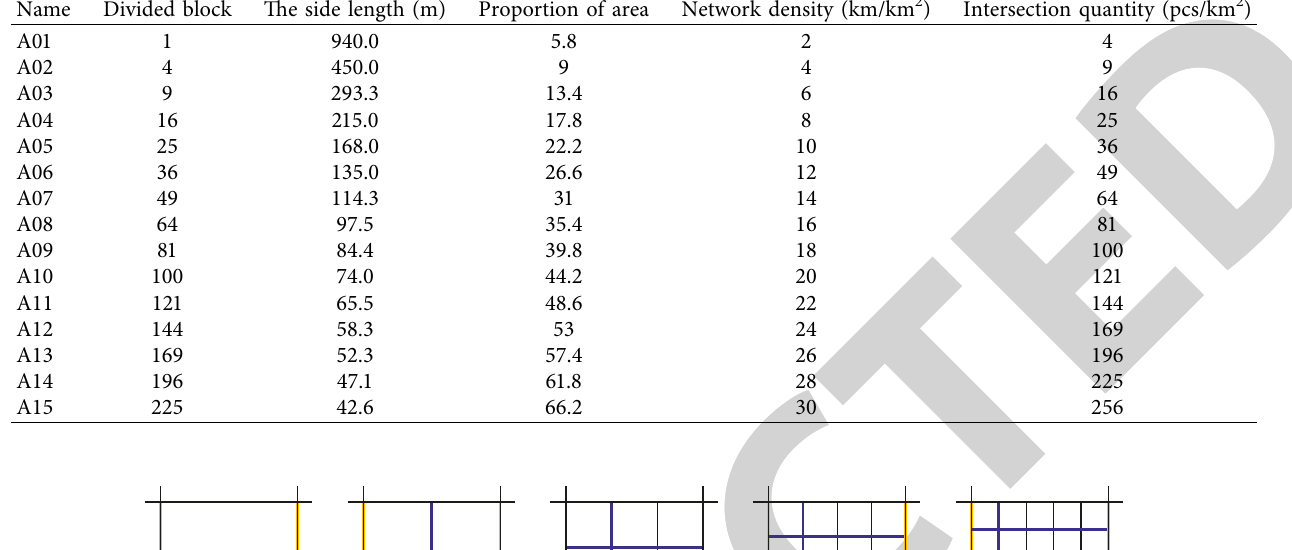
Table 4: Fifteen numerical intervals set by the square block model.